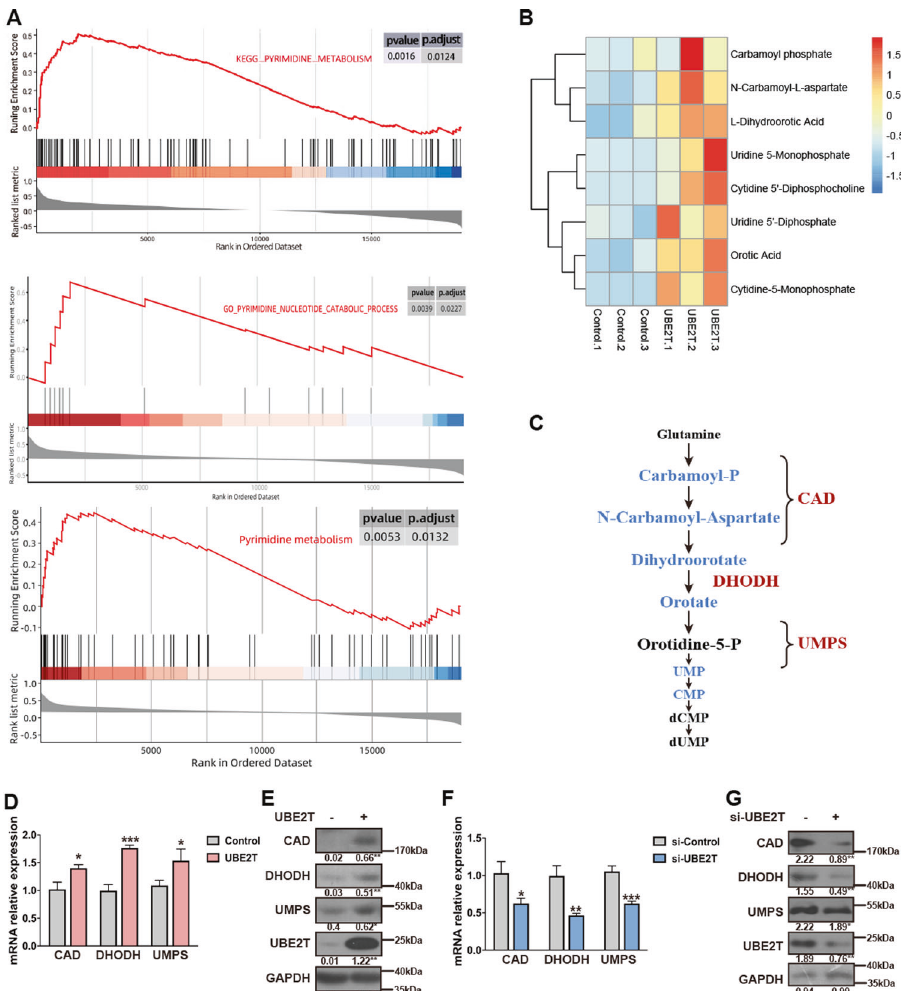
Fig. 3 UBE2T regulates pyrimidine metabolism in HCC cells. A Results of GSEA were plotted to visualize the correlation between the expression of UBE2T and gene signatures of pyrimidine metabolism in the TCGA cohort. B LC-MS/MS-based metabolomics pro fi ling analysis was conducted to analyze UBE2T-overexpressing and control HCC-LM3 cells, and the results of unbiased hierarchical clustering was presented. C Schematic of the de novo pyrimidine synthesis pathway. D The mRNA levels of the indicated genes were detected by qRT-PCR analysis in UBE2T-overexpressing and control HCC-LM3 cells. E The protein levels of the indicated genes were detected by WB analysis in UBE2T- overexpressing and control HCC-LM3 cells. F The mRNA levels of the indicated genes were detected by qRT-PCR analysis in UBE2T-silencing and control MHCC-97H cells. G The protein levels of the indicated genes were detected by immunoblotting analysis in UBE2T-silencing and control MHCC-97H cells. All values shown are mean ± SD of triplicate measurements and experiments, * P < 0.05, ** P < 0.01, *** P < 0.001, **** P < 0.0001. In D and F , a two-tailed Student ’ s t -test was used for comparing the two groups. The average gray values and the statistical data were shown under the corresponding band. Student ’ s t -test was used for comparisons, * P < 0.05, ** P <